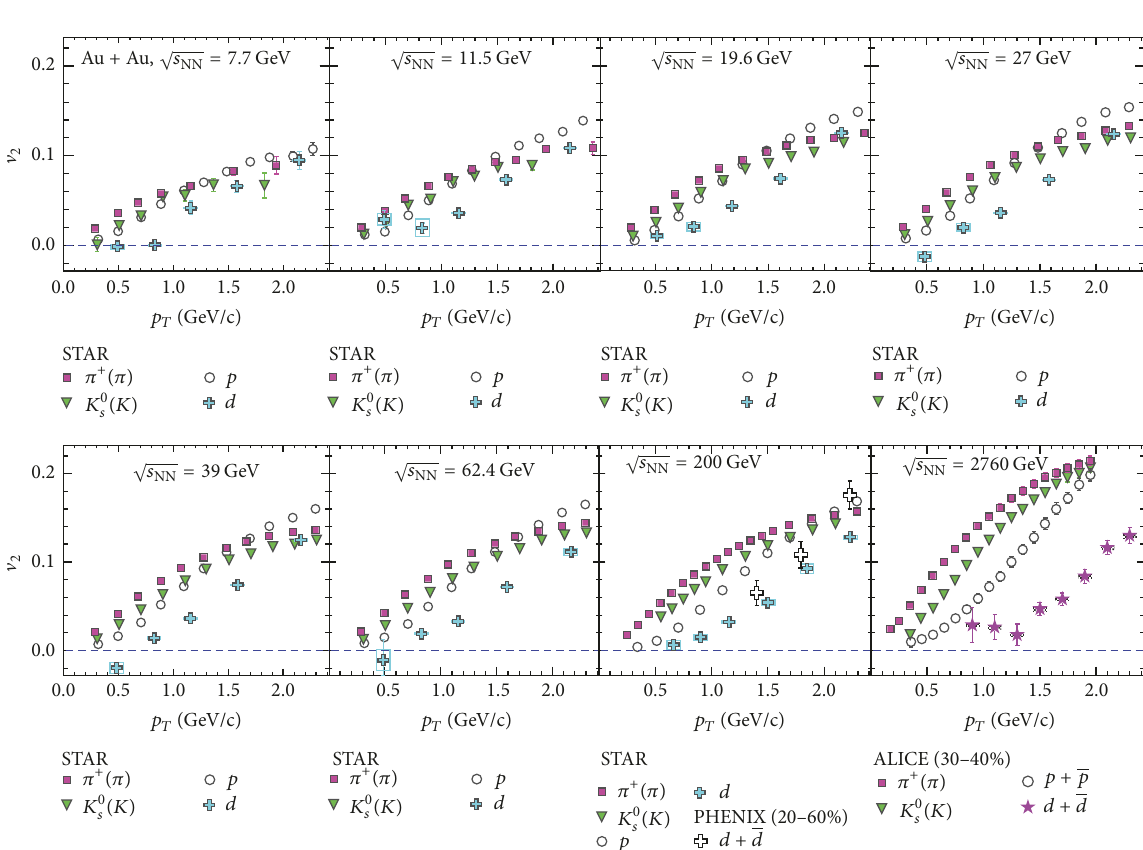
Figure 2: Midrapidity V 2 (𝑝 𝑇 ) for 𝜋 + (squares), 𝐾 0 𝑠 ( 𝐾 in Pb + Pb) (triangles), 𝑝 (open circles), and 𝑑 (crosses) in 0–80%, 20–60%, and 30–40% centrality from STAR, PHENIX, and ALICE,